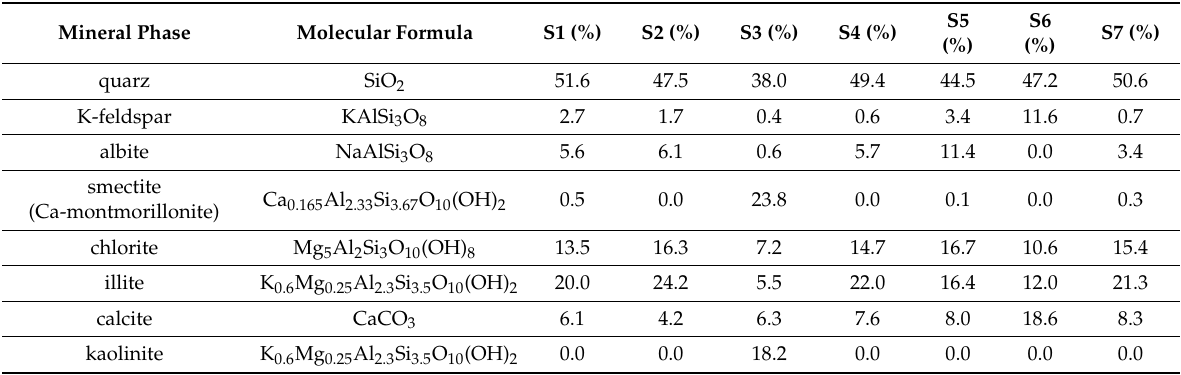
Table 3. Mineralogical composition of the seven samples (S1, S2, S3, S4, S5, S6, and S7) as obtained from quantitative analyses. Phases are reported as % in weight. Mineral